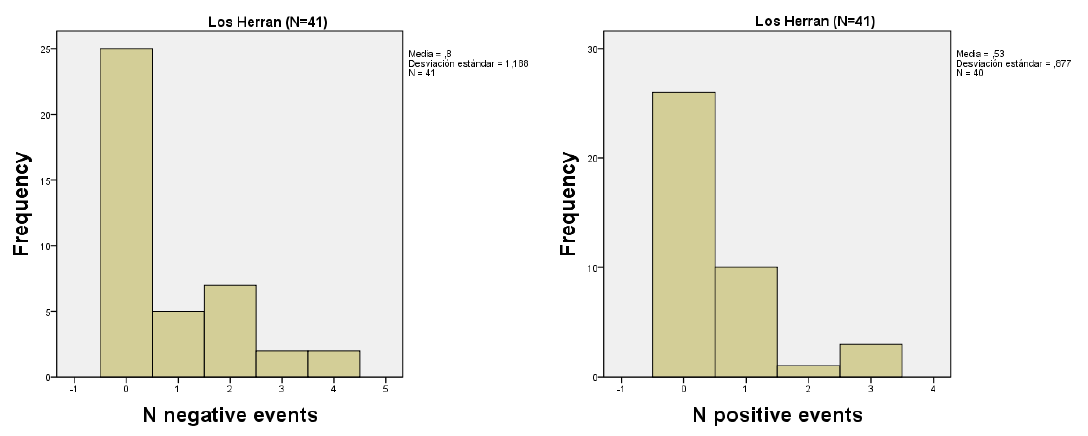
Figure 6: Number of noise events identified by the system during the observation at one place and evaluated as negative by participants. A total of 41 observations were developed.